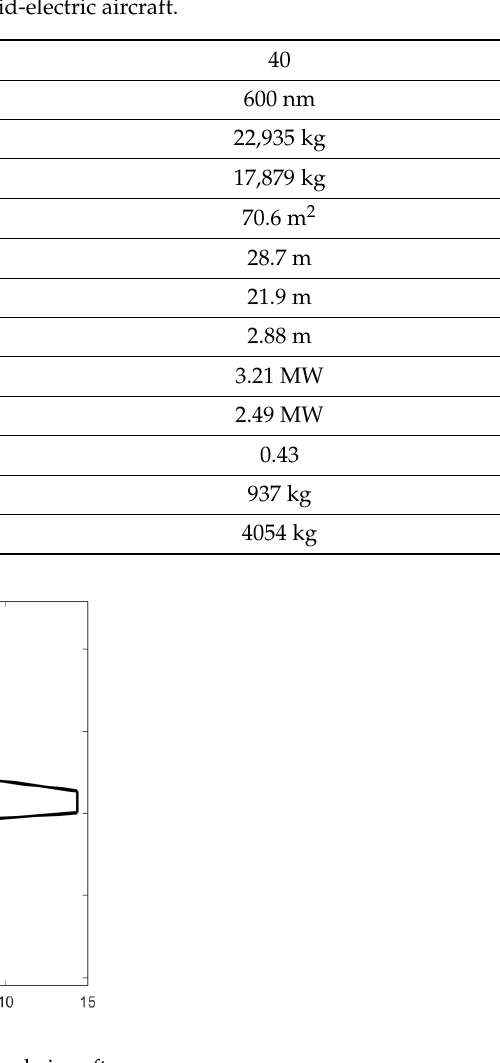
Figure 9. Mission simulation outcomes: trajectory (left), slope angle (centre), lift – drag ratio (right).